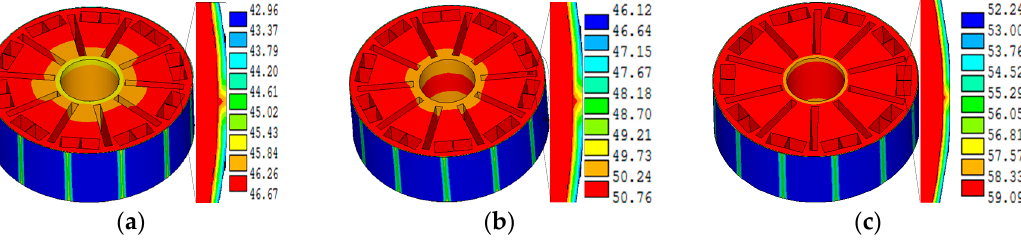
Figure 9. Temperature distribution of the rotor core under different AMMF (°C); ( a ) 0 At AMMF; ( b ) 600 At AMMF; and, ( c ) 900 At AMMF.